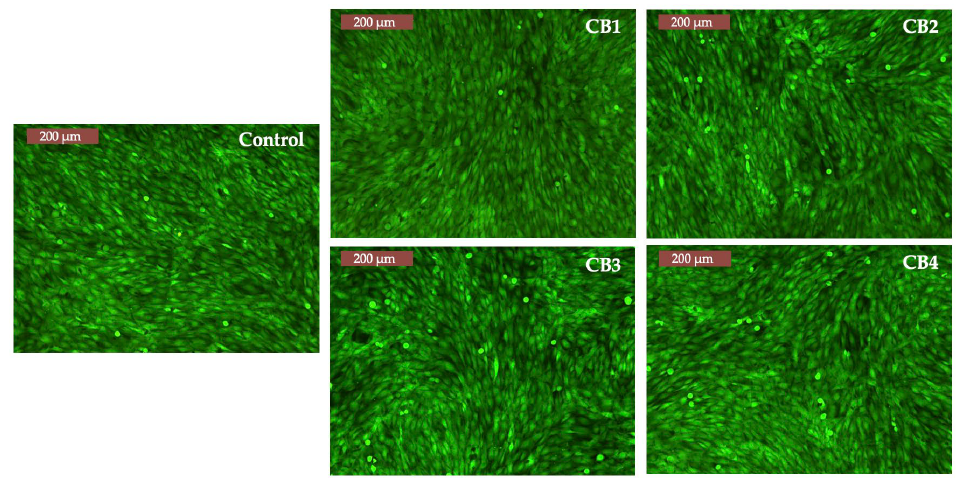
Figure 10. Fluorescent images of MG - 63 cells in contact with CBs (72 h ) Inverted Phase Contrast Microscope (Leica, Germany)